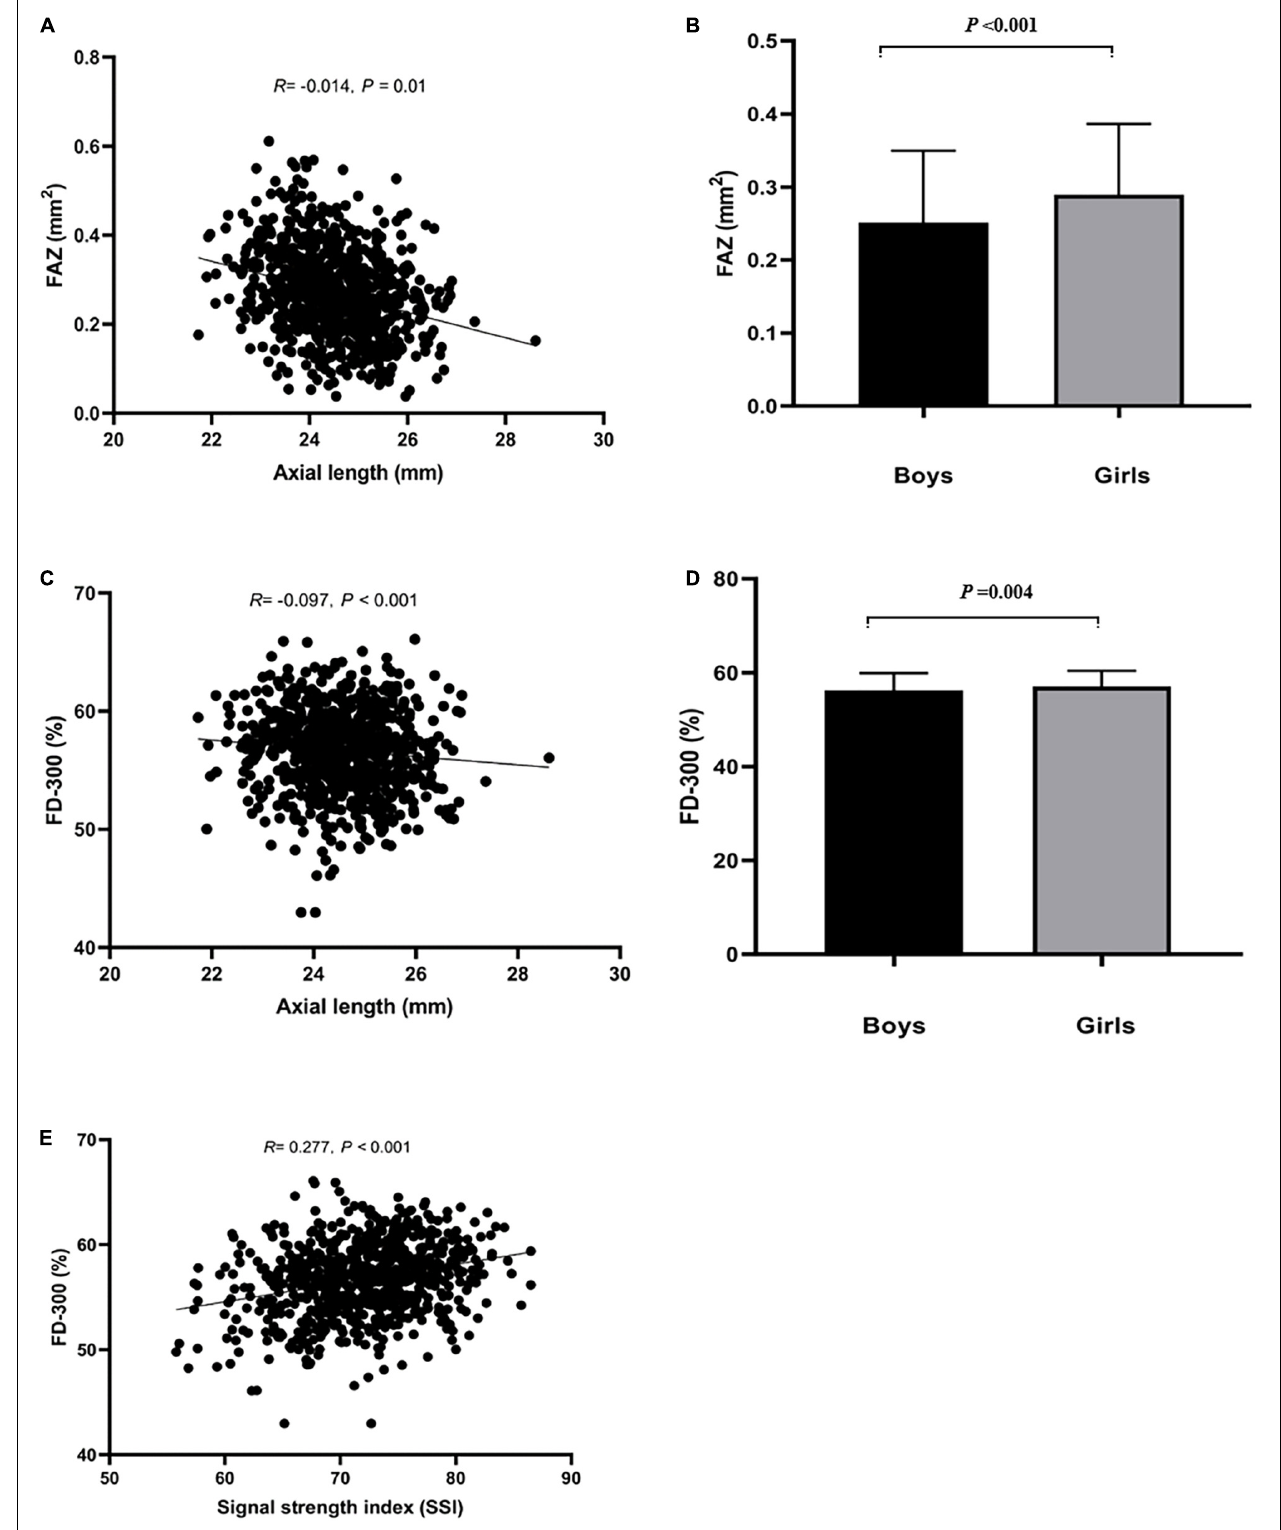
FIGURE 2 | Relationship between FAZ, FD-300 and axial length (mm), SSI, and sex. (A,B) Represented that axial length and sex influenced FAZ. (C–E) Represented that axial length, SSI and sex influenced FD-300.